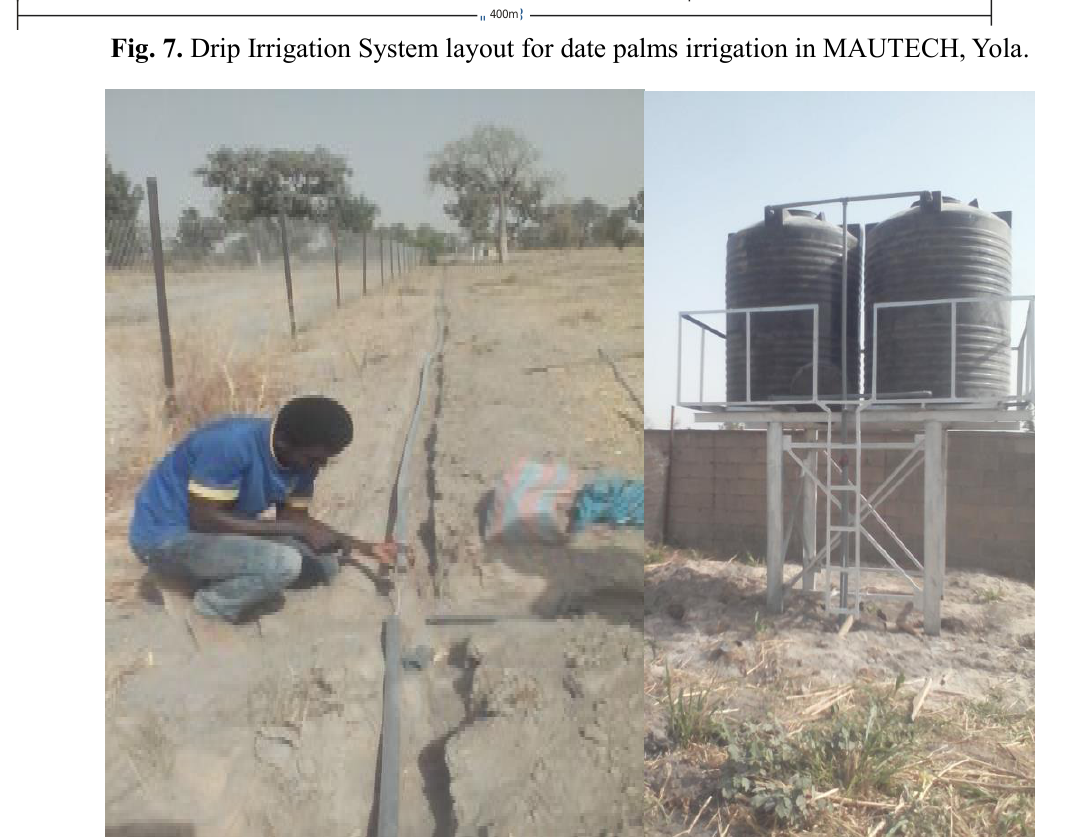
Fig. 8. The pipes layout for the drip irrigation system and overhead tank in the research